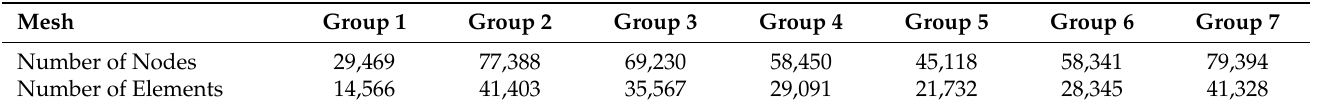
Table 3. The number of nodes and elements after meshing in each